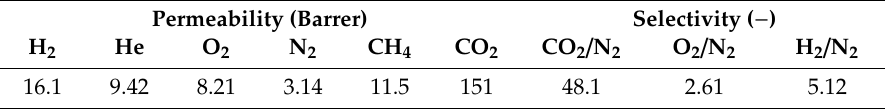
Table 5. Permeation data measured on a Pebax ® 1657 / T80 (50 / 50 wt %) membrane after an aging time of 20